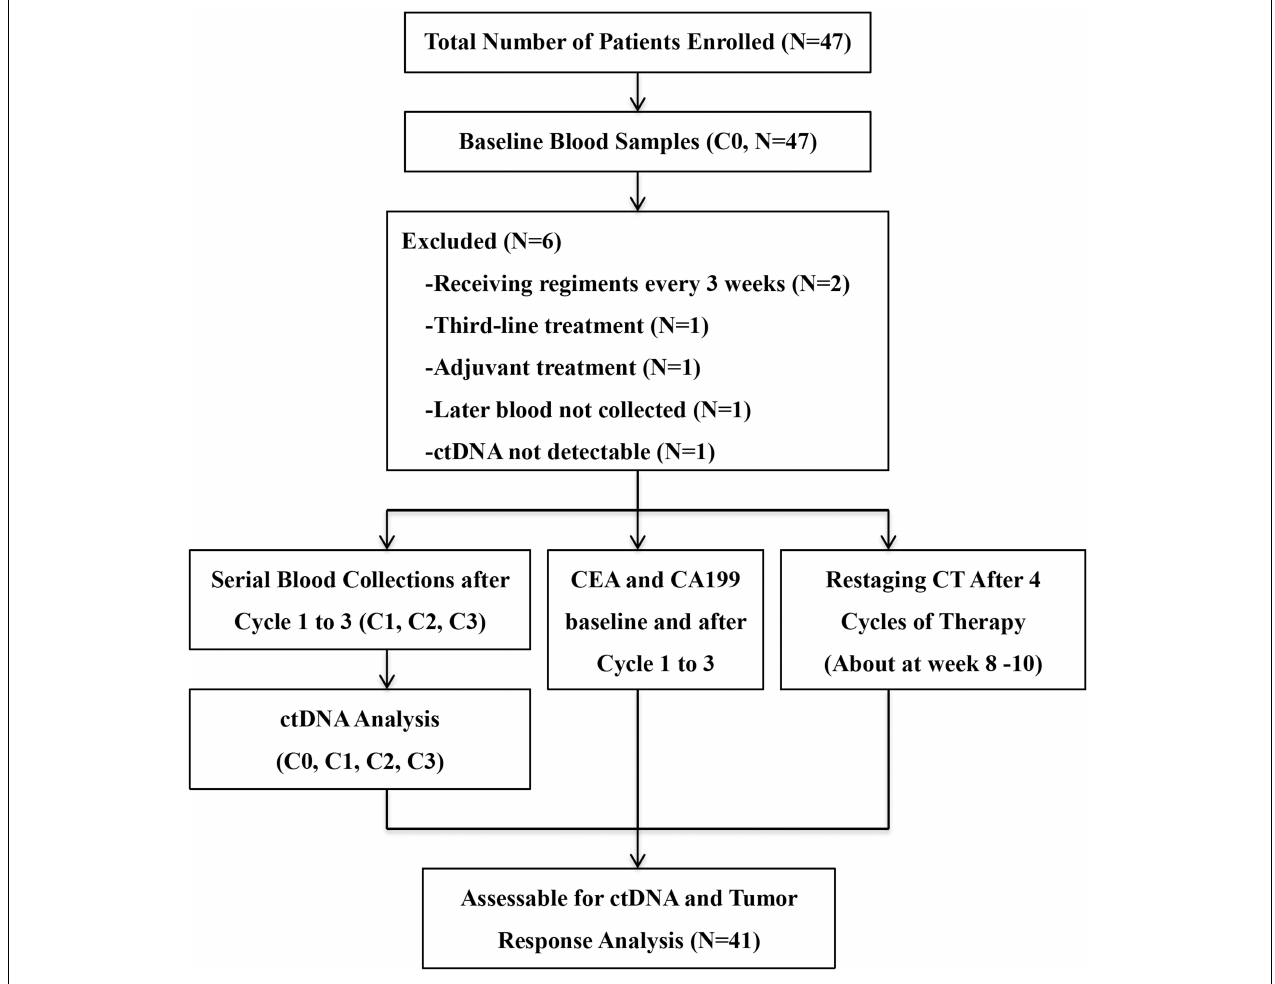
FIGURE 1 | Workflow of the